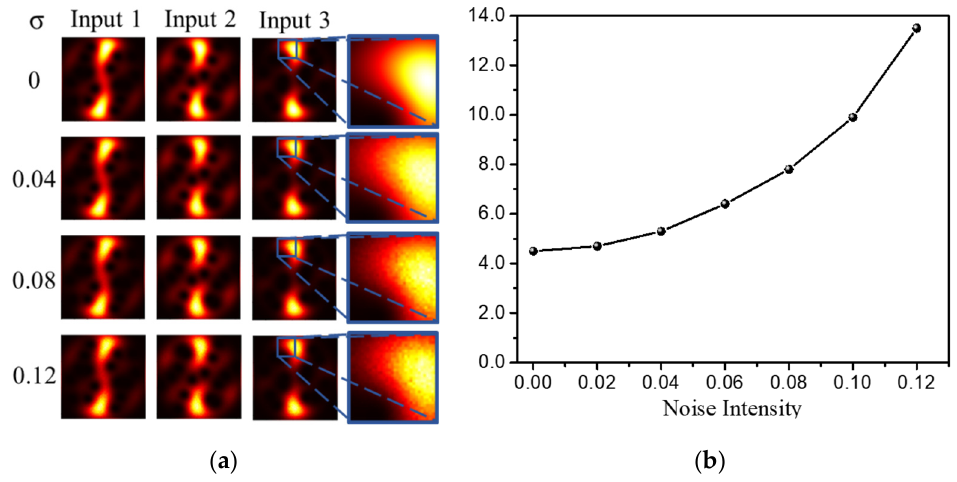
Figure 7. The performance of CNN for noisy input profiles. ( a ) Input profiles under different noise intensities; ( b ) The relation between mode weight error and noise intensity.